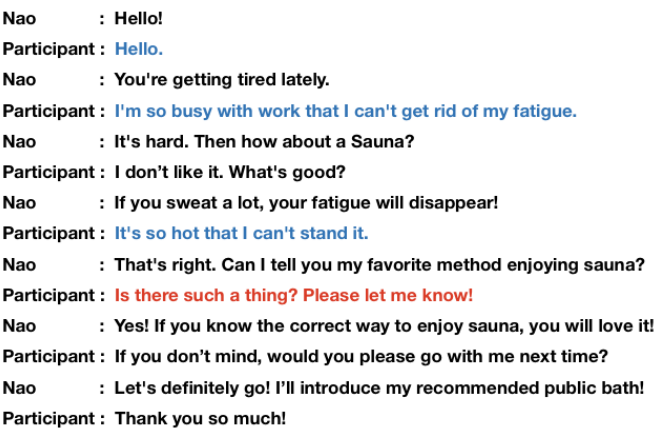
Figure A2. Content regarding the topic of sauna in scenario set